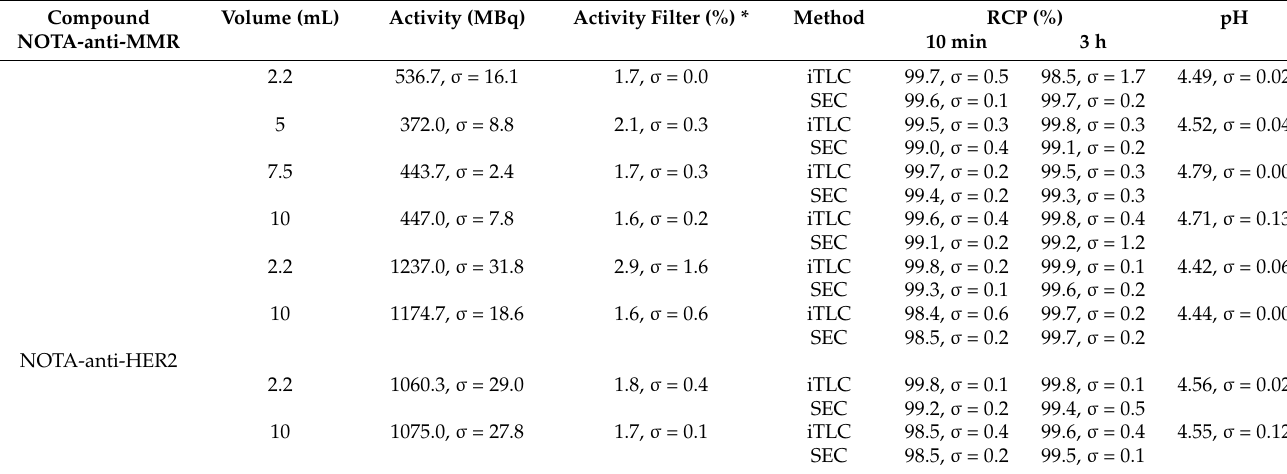
Table 6. Exploratory and confirmation study of combining 20%EtOH with 5 mg AA (fixed) in increasing radiolabeling volumes. Compound